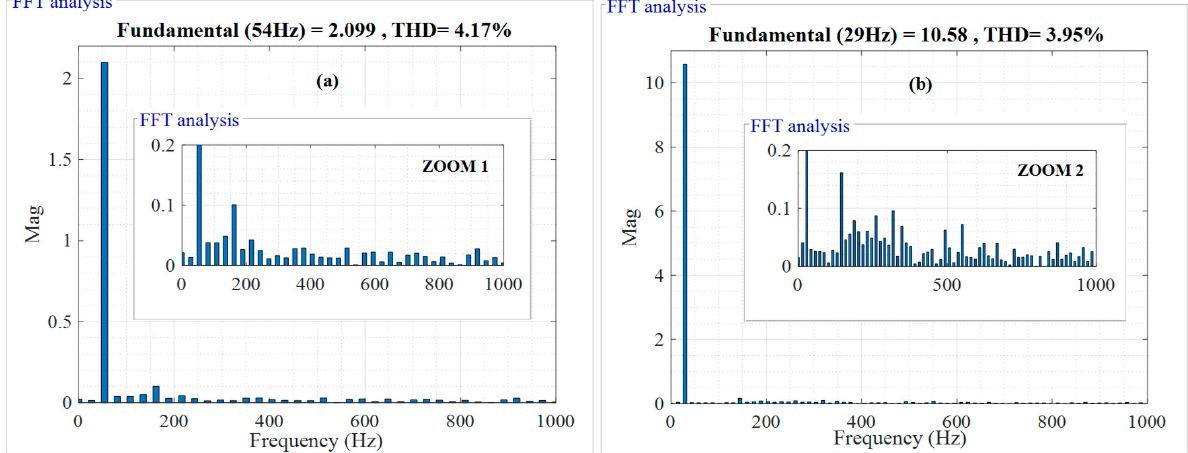
Figure 14. Stator ( a ) and rotor ( b ) current THD of the GA–DTC.